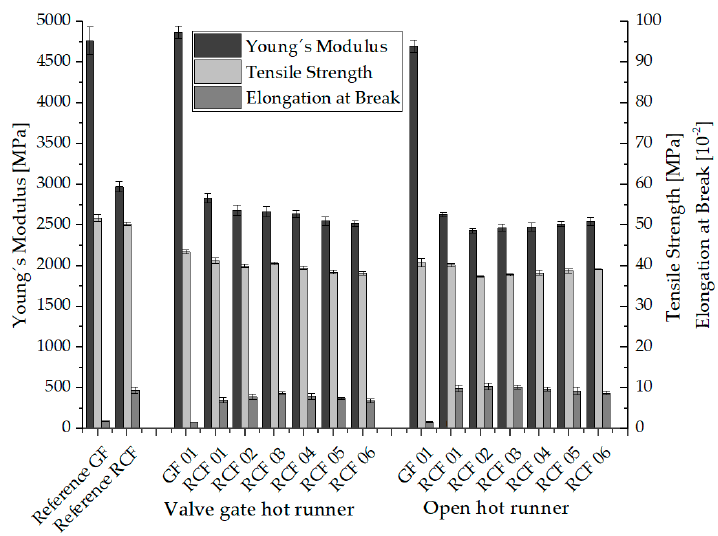
Figure 4. Mechanical properties of the RCF and GF reinforced composites.